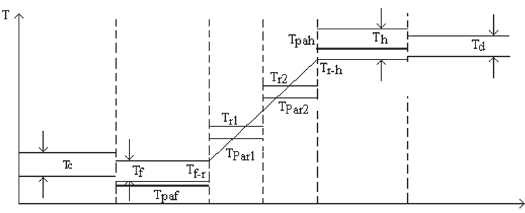
Figure 8: Temperature distribution.